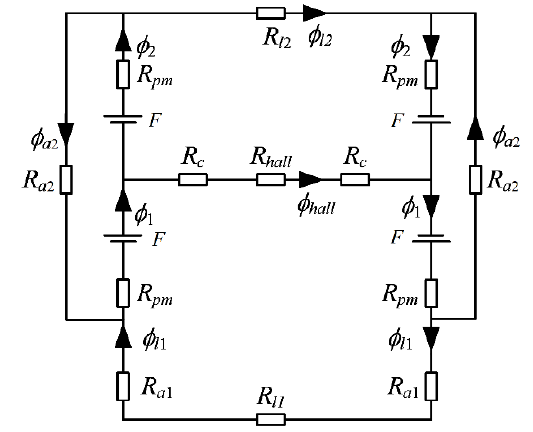
Figure 2. Equivalent magnetic circuit of the bridge-structured PM-MFM sensor.